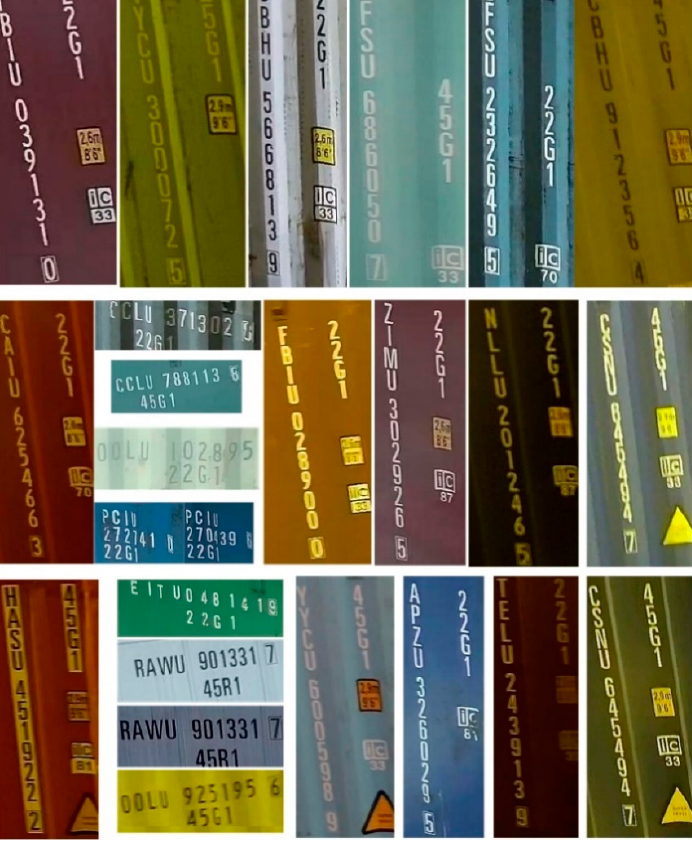
Figure A1. Some images of the self ‐ built dataset in this paper.